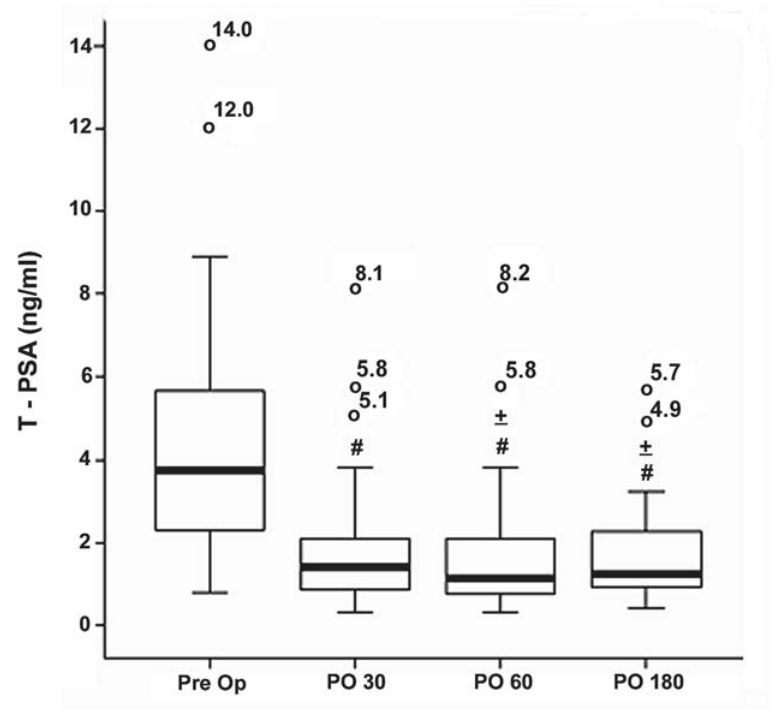
Figure 2 – T-PSA at baseline and postoperative days 30, 60 and 180. (# p < 0.001 compared to preoperative; ± p = 0.035 compared to PO day